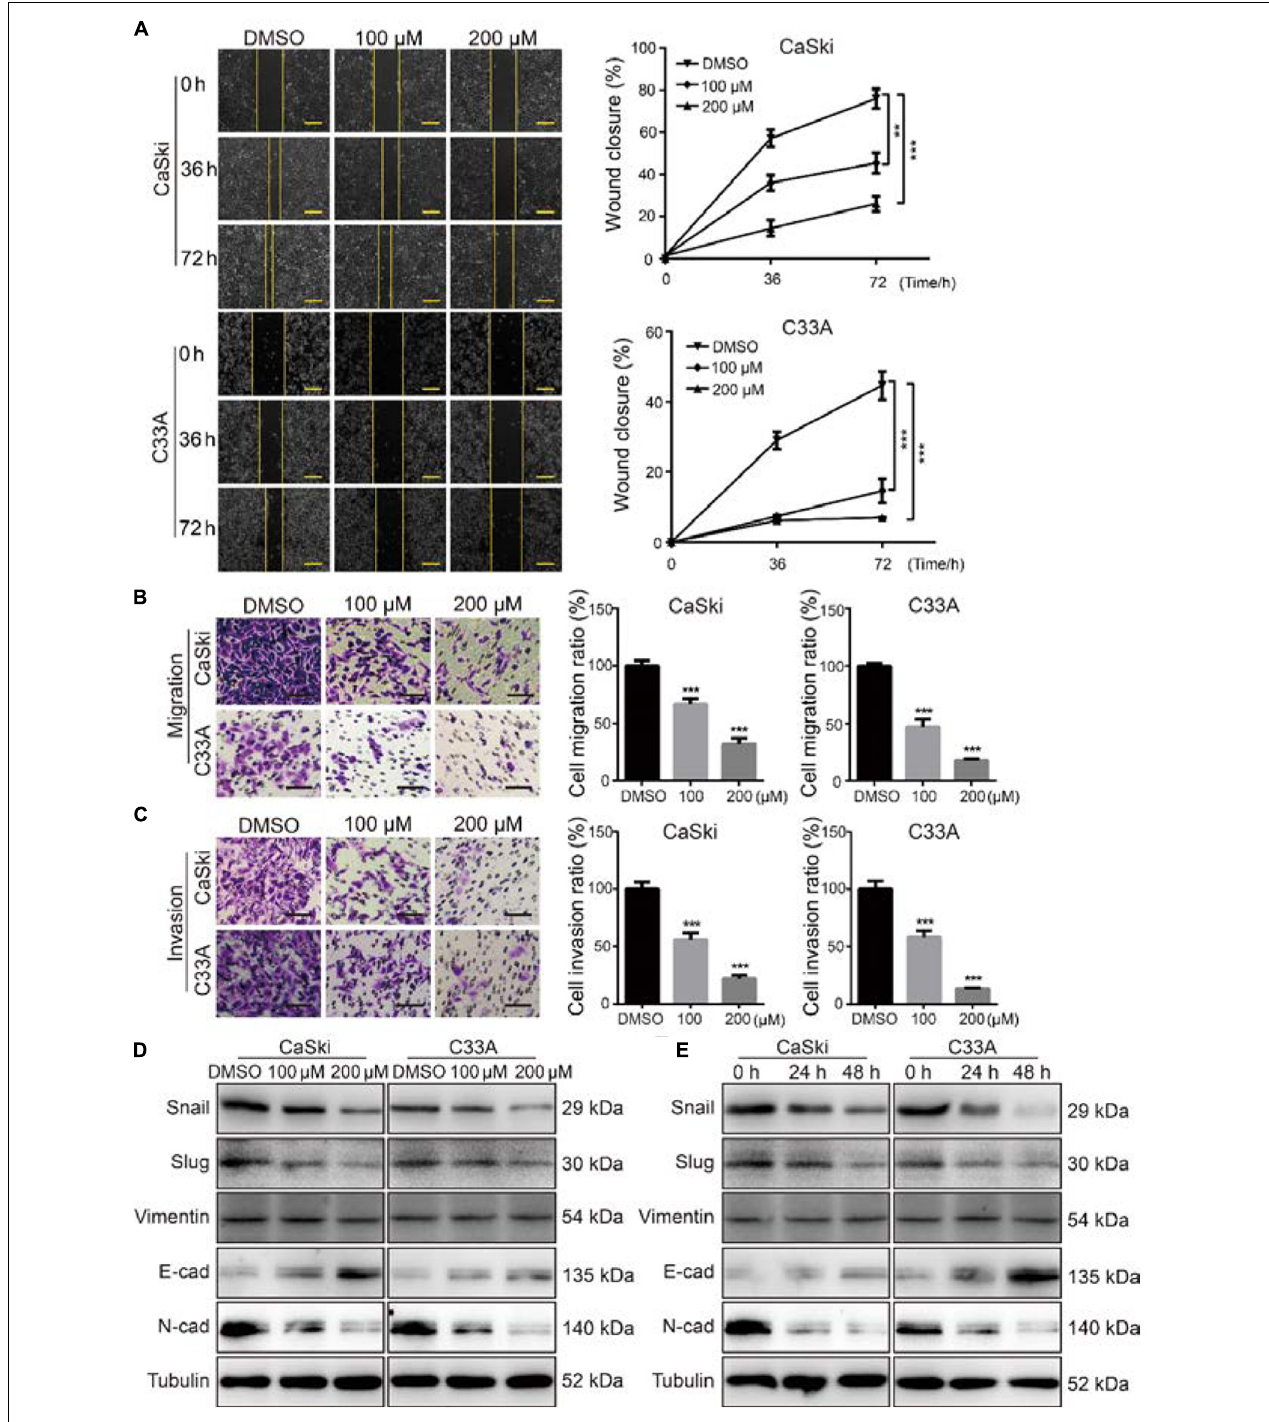
FIGURE 3 | Polydatin inhibited cervical cancer cell migration and invasion. (A) The migration by wound-healing assays of CaSki and C33A cells after treating with dimethyl sulfoxide (DMSO) or polydatin at the indicated concentrations for the indicated time. Scale bar, 100 µ m. (B) The effect of Transwell migration assays in CaSki and C33A cells after treating with DMSO or polydatin at the indicated concentrations for 24 h. Scale bar, 100 µ m. (C) The effect of Transwell invasion assays in CaSki and C33A cells after treating with DMSO or polydatin at the indicated concentrations for 48 h. Scale bar, 100 µ m. (D,E) Western blot analysis of the EMT-related protein levels in CaSki and C33A cells. Cells were treated with polydatin at indicated concentrations or at indicated time. Tubulin was used as a control. All data were analyzed using two-tailed Student’s tests. Error bars, ∗ P < 0.05, ∗∗ P < 0.01, and ∗∗∗ P < 0.001.